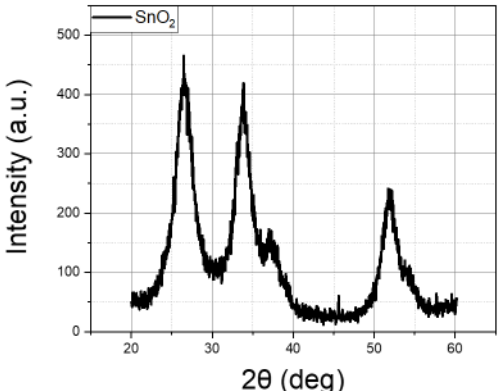
Figure 10. The XRD pattern for SnO 2 .